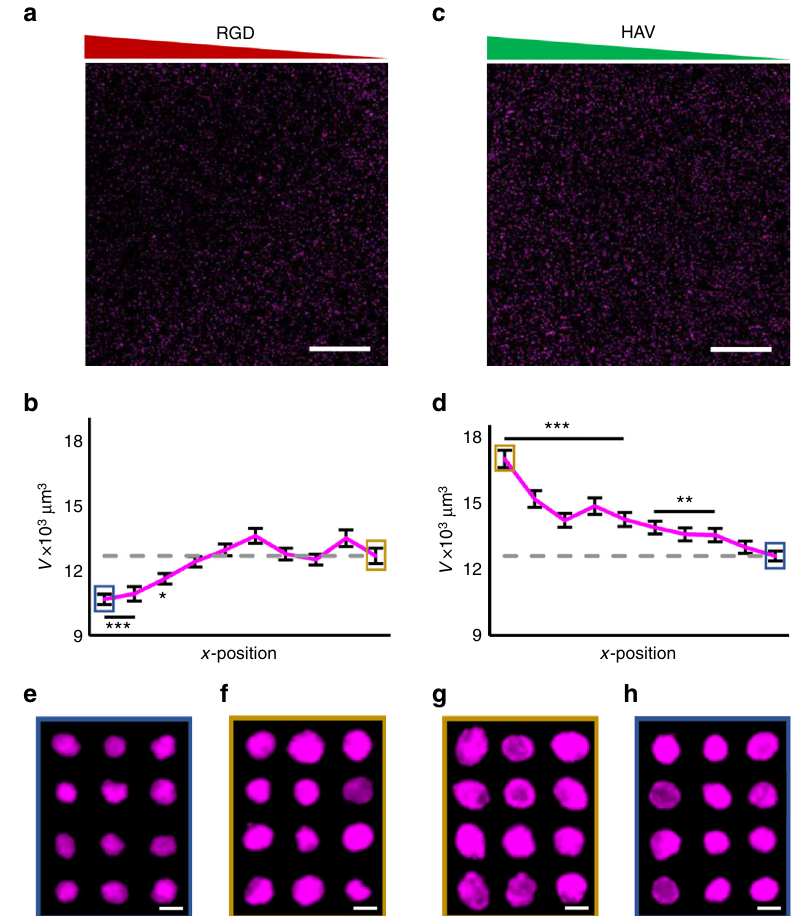
Fig. 3 Effects of HAV and RGD gradients on aggrecan synthesis. Maximum projection images and quanti fi cation across 10 regions of aggrecan fl uorescence (magenta) for gradients of a , b RGD and c , d HAV peptides after 7 days. Representative maximum projection images of aggrecan in e high or f low RGD regions and g high or h low HAV regions. Generally, larger aggrecan volumes were observed with decreasing RGD and for increasing HAV peptide levels. Error bars represent standard error around the mean (s.e.m.); n > 300 cells per zone, *** p < 0.001, ** p < 0.01, * p < 0.05 compared to lowest peptide region (gray dashed line). Scale bars: a , c 1 mm, e – h 25 µ